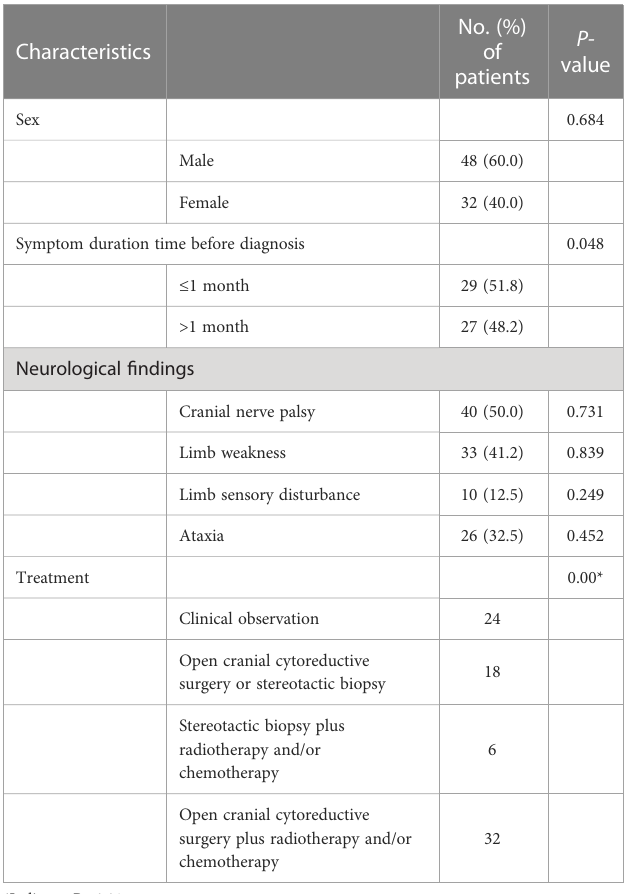
TABLE 1 Clinical parameters correlated with OS of 80 DIPGs.